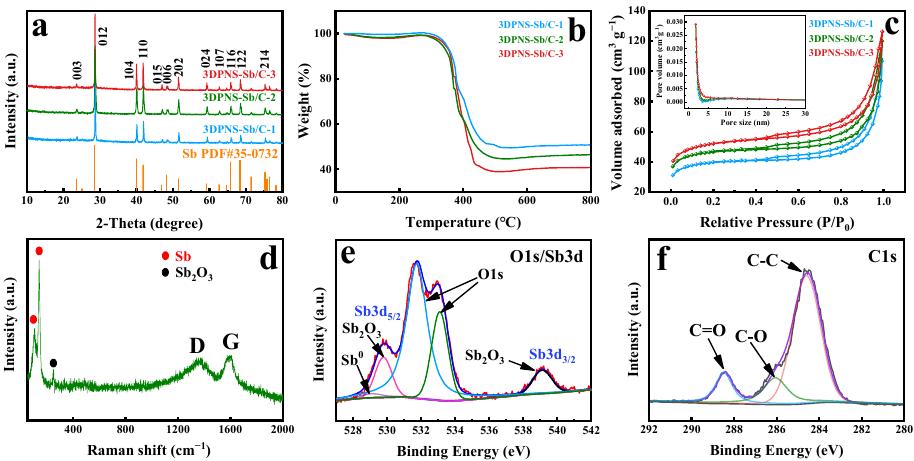
Figure 3. ( a ) XRD patterns of 3DPNS-Sb/C-1, 3DPNS-Sb/C-2 and 3DPNS-Sb/C-3. ( b ) TG curves of 3DPNS-Sb/C-1, 3DPNS-Sb/C-2 and 3DPNS-Sb/C-3. ( c ) Nitrogen adsorption–desorption isotherms and related pore dimension distribution curves of 3DPNS-Sb/C-1, 3DPNS-Sb/C-2 and 3DPNS-Sb/C-3. ( d ) Raman spectra of 3DPNS-Sb/C-2. XPS spectra of 3DPNS-Sb/C-2: ( e ) Sb 3d and O 1s, ( f ) C 1s.